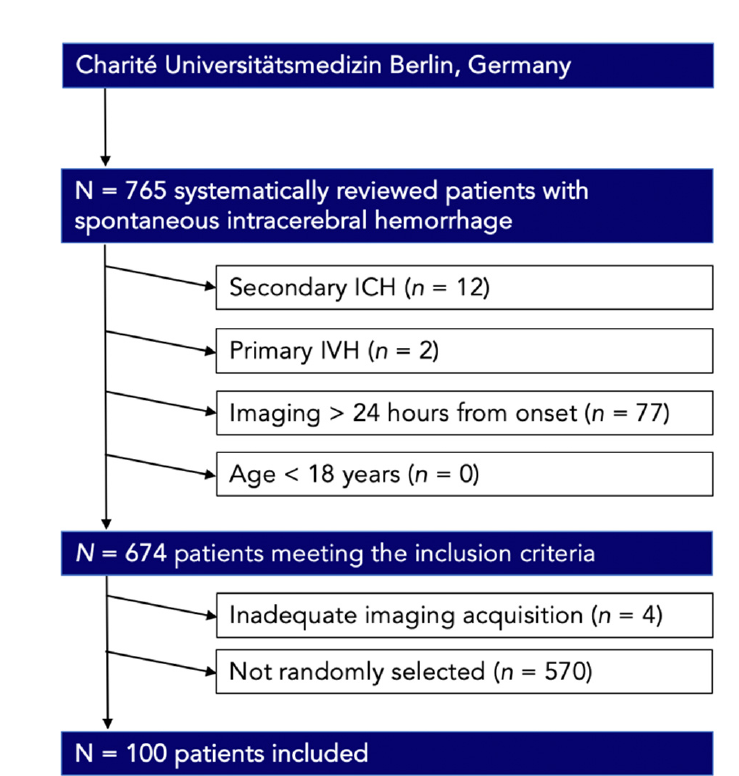
Figure 1. Patient flowchart indicative of the final subset according to the inclusion criteria. IVH, intraventricular hemorrhage.